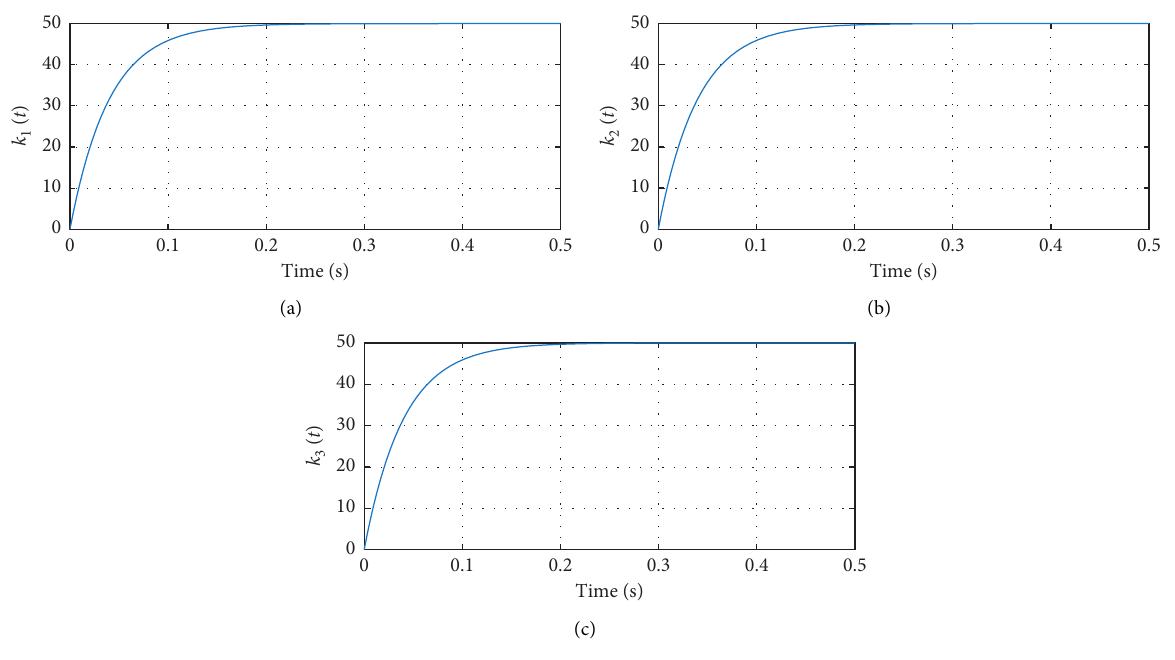
Figure 5: Observer gain of TVGDO (Case